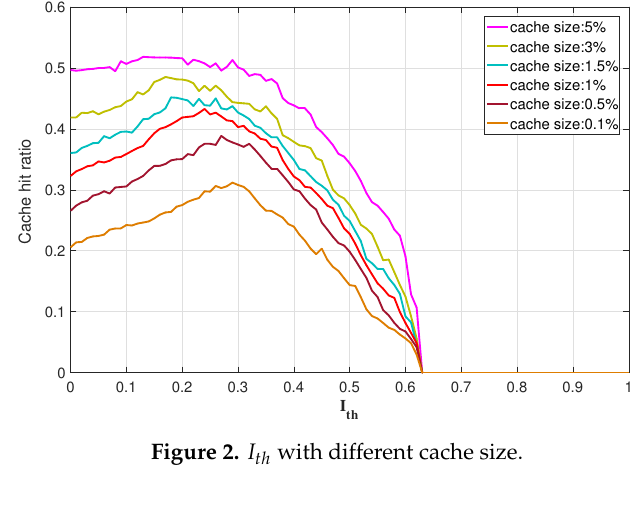
Figure 2. I th with different cache size.